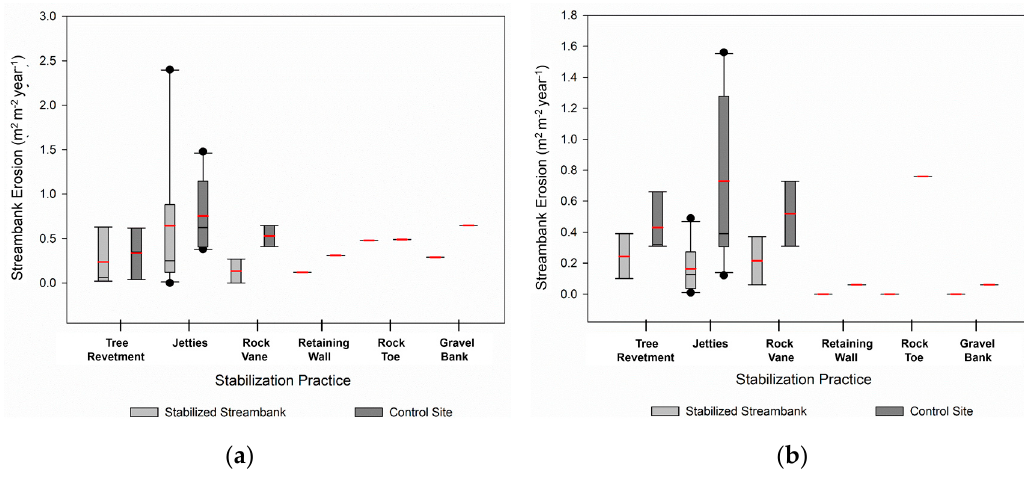
Figure 6. Boxplots illustrating the streambank erosion rates for the pre-stabilization ( a ) and post-stabilization ( b ) periods for the stabilized streambanks and control sites. Red lines indicate the mean erosion rates. Table 2. Calculated streambank erosion rate for each site compared with the corresponding control site(s). Each control site value is an average of erosion of one to three identified control sites.